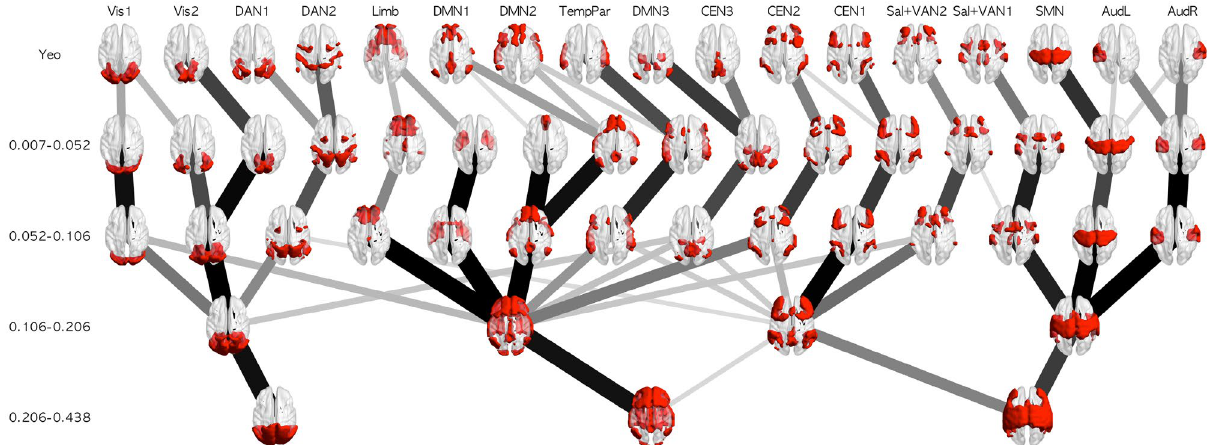
Figure 2. Network architectures from the data of Yeo et al. 5 and each frequency band. The line width and color reflect the overlap ratio between networks. This figure was created using Matlab 2017a (Mathworks, USA) with BrainNet Viewer 1.7 58 and python 3.6.0 with scikit-image 0.19.3, Pillow 9.4.0, and matplotlib 3.6.3.